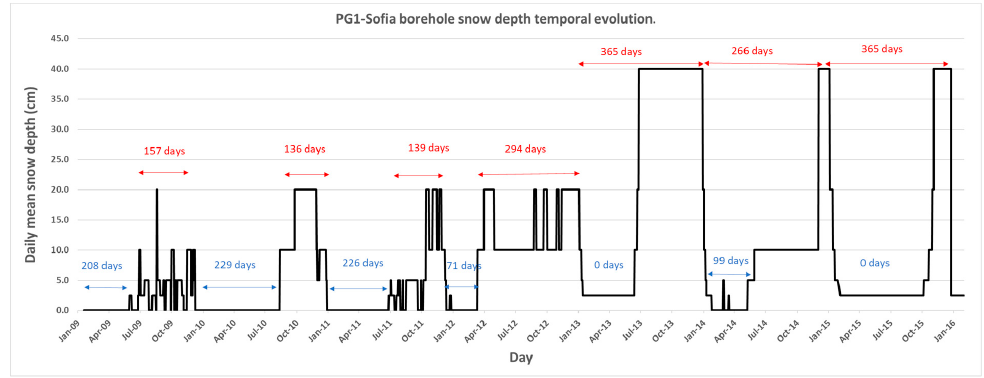
Figure 4. Snow thickness in PG1 from 2009 to 2015. Table 3. Characteristics of the snow cover thickness at the two borehole sites (m · day). PG1 PG2